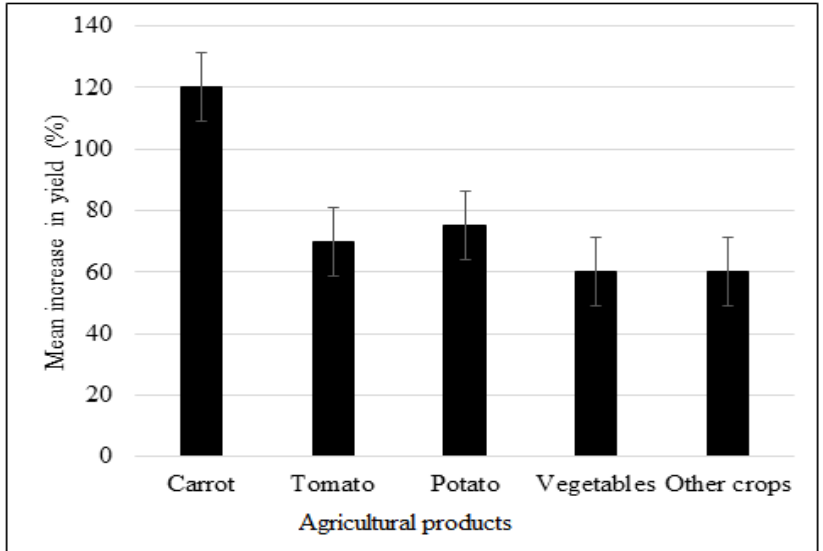
Figure 10. Mean percentage increment in crop yields of household farmers (intervention pilot) compared to non-intervention pilot (Source: Elaborated by the